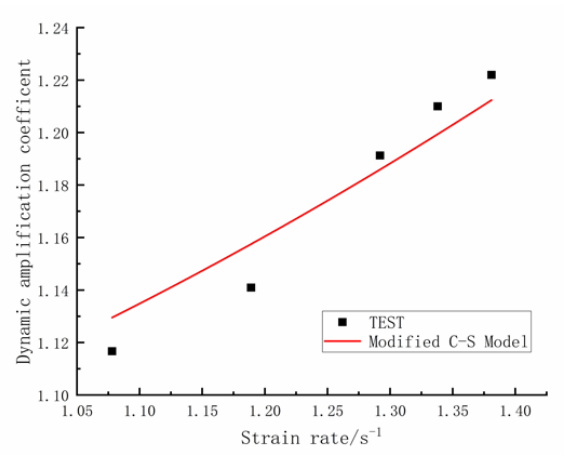
Figure 7. Cowper–Symonds model fitting curve of DIF u.